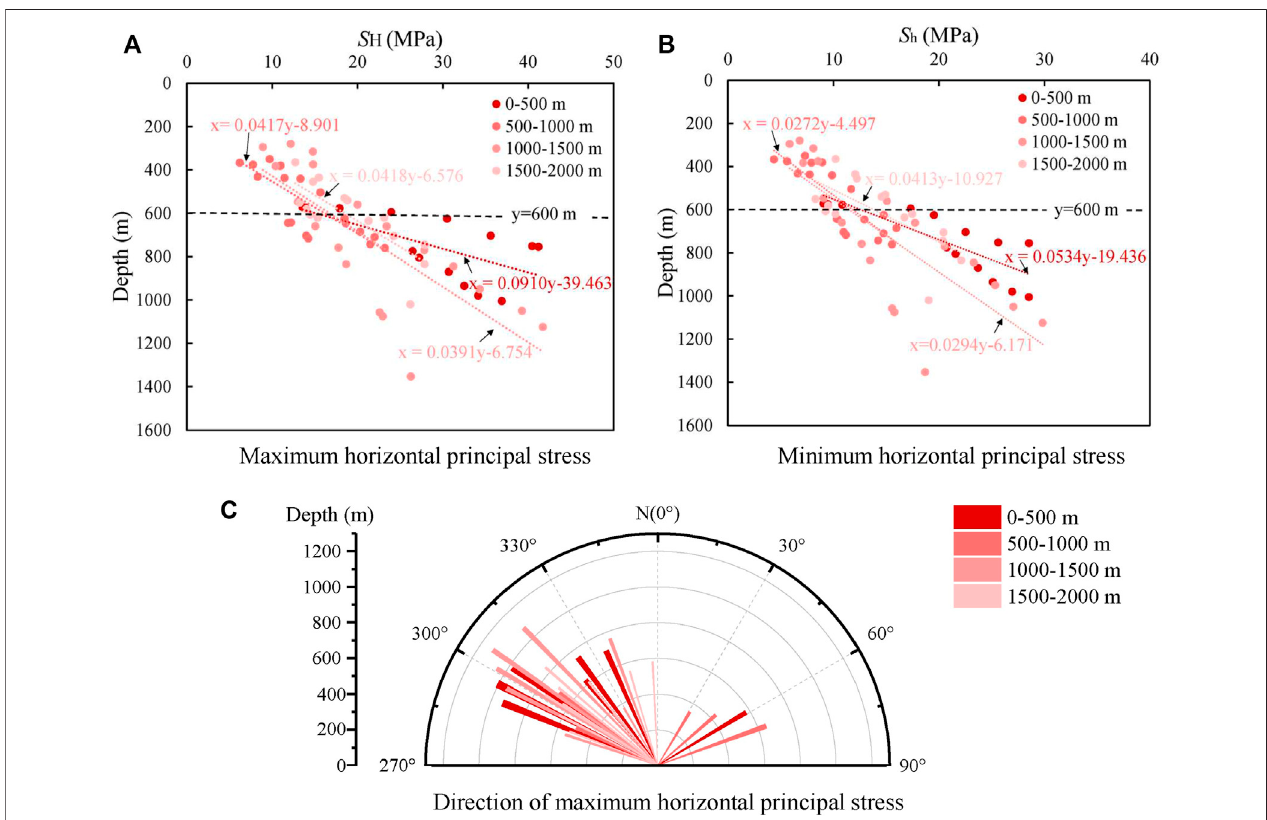
FIGURE 7 | In-situ stress at different spatial locations (A) Maximum horizontal principal stress (B) Minimum horizontal principal stress (C) Direction of maximum horizontal principal stress.